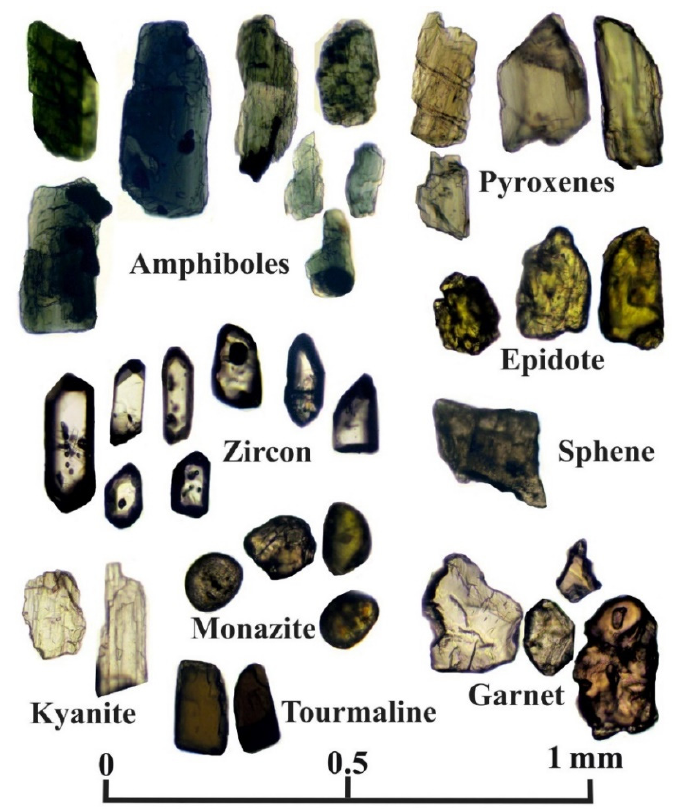
Figure 3. Photomicrographs of identified heavy minerals.